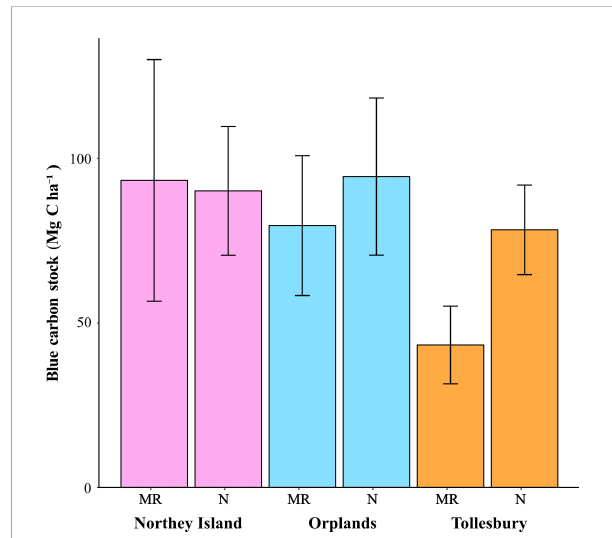
FIGURE 2 Mean carbon stock ± standard deviation in the top 30cm of soil for managed realigned (MR) and natural (N) saltmarsh sites at Northey Island (pink), Orplands (blue) and Tollesbury (orange) in the Blackwater Estuary, Essex,